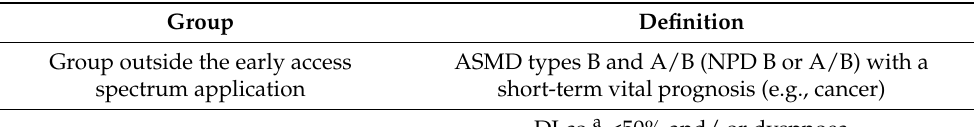
Table 4. Patients with chronic ASMD grouped among disease severity (CETLv classification).